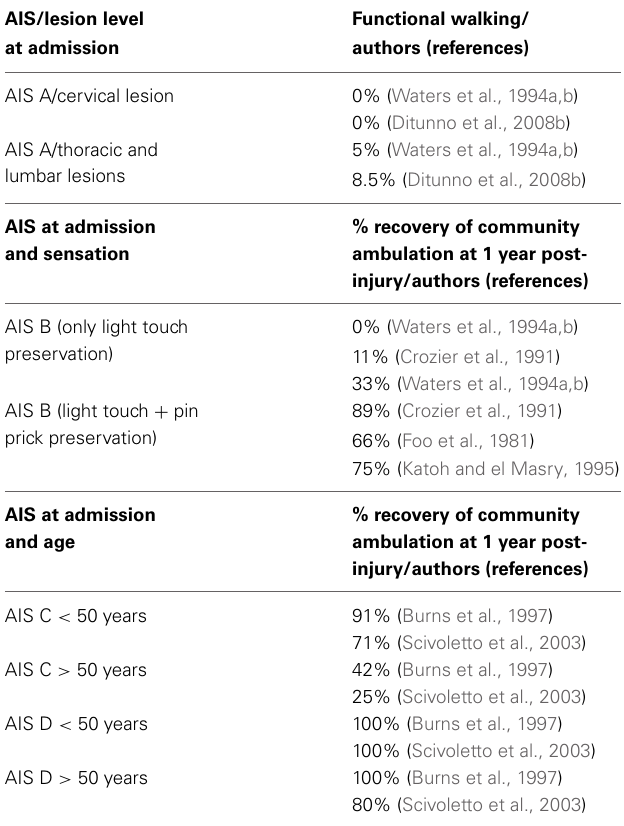
Table 2 | Prediction of functional walking according to AIS impairment and other